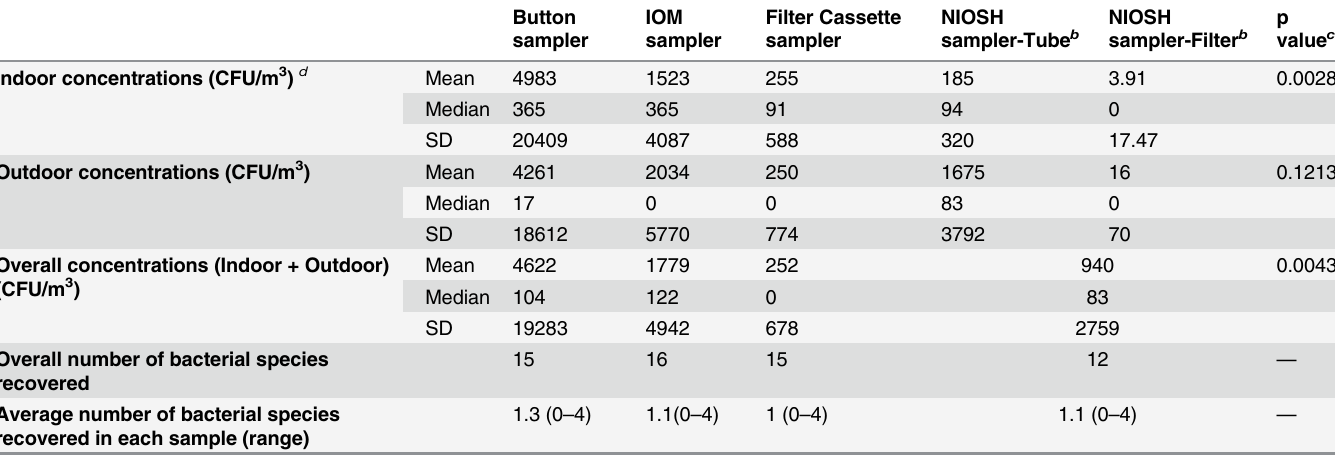
Table 3. Relative efficiency comparison of personal samplers based on culturable bacterial concentrations and diversity.